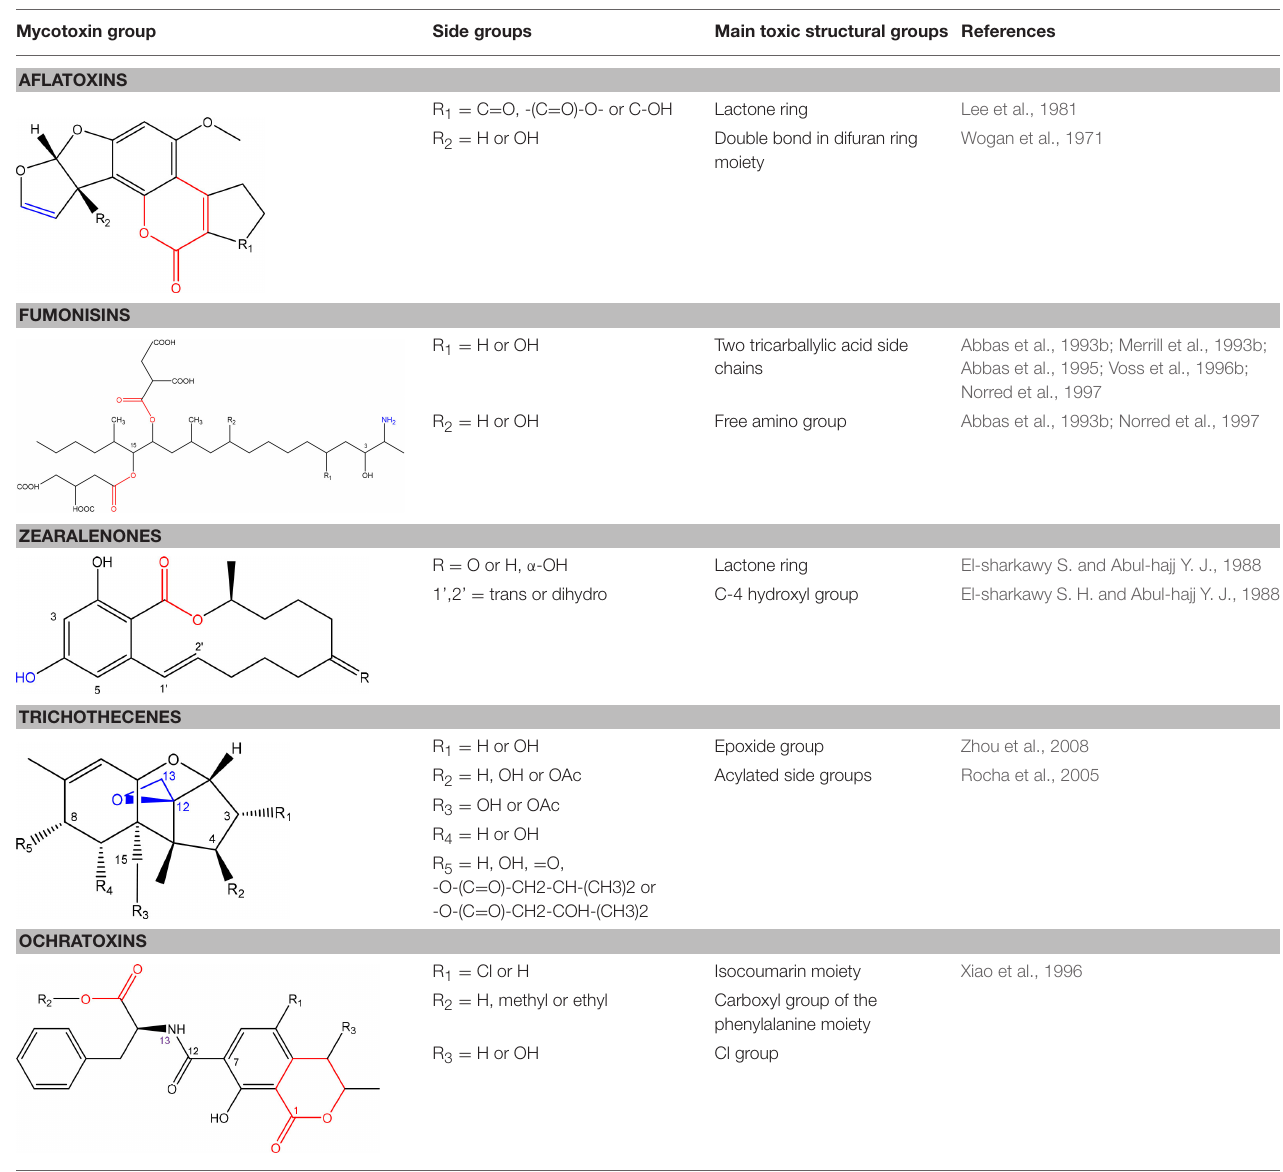
TABLE 1 | Chemical structural groups inferring toxicity in